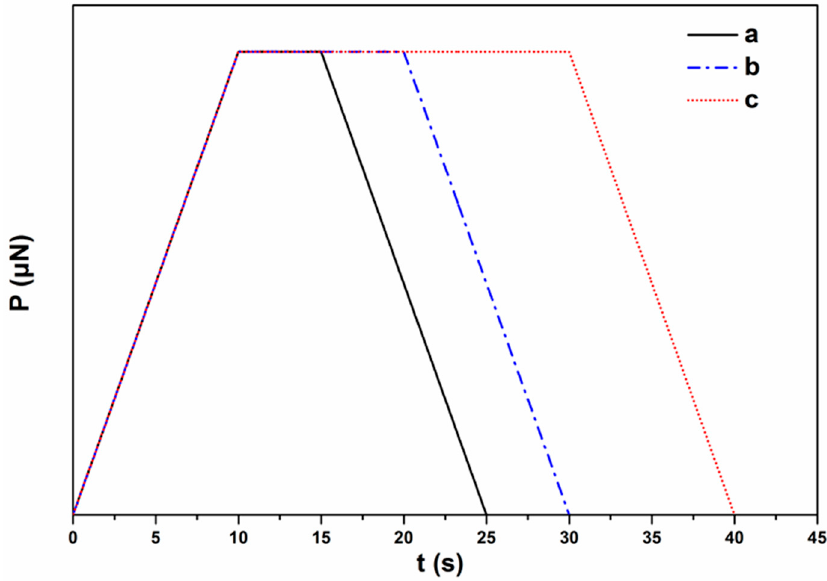
Figure 8. Loading functions for (a) 5, (b) 10, and (c) 20 s holding time at a fixed rise time (10 s).